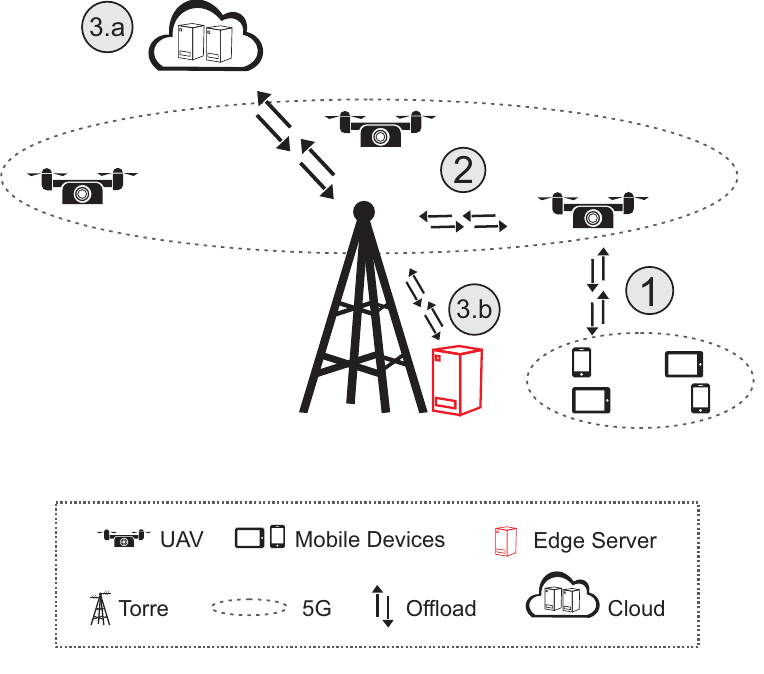
Figure 4. Extended architecture, with the addition of an edge